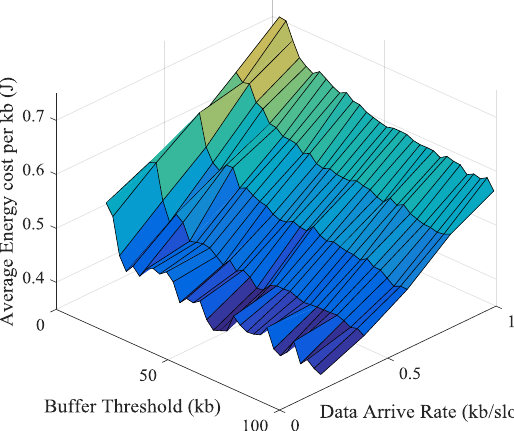
Figure 29. Simulation results of the impact of buffer threshold and data arrival rate on the average energy cost.